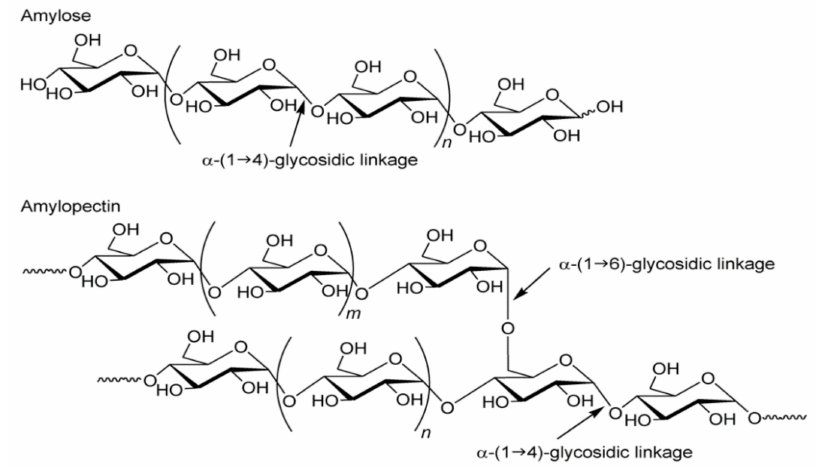
Figure 1. Structure of amylose and amylopectin